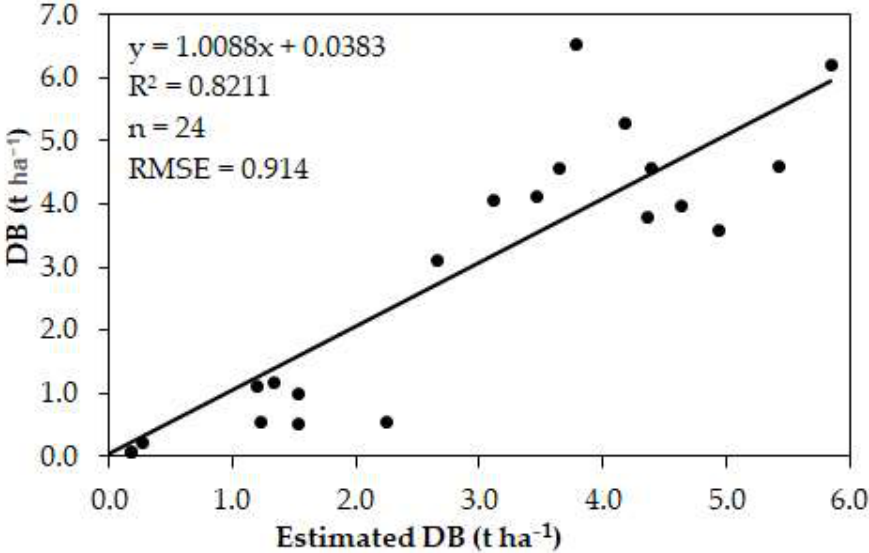
Figure 5. Validation for the model using combinatory regression with H DSM and TCVI.